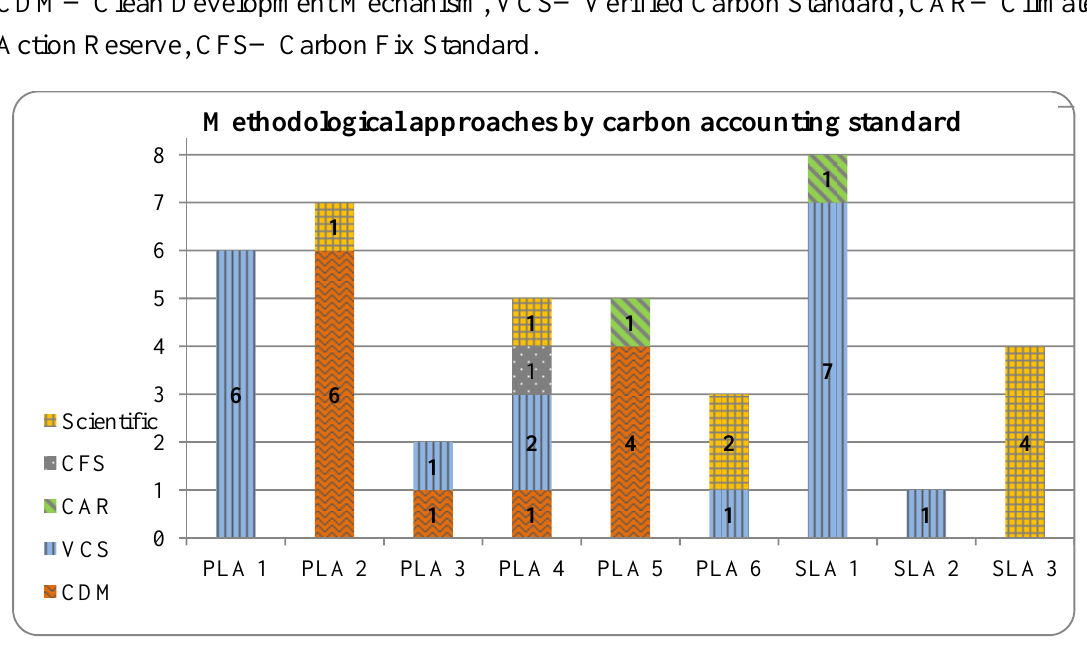
Figure 1. Leakage quantification methods applying the nine main